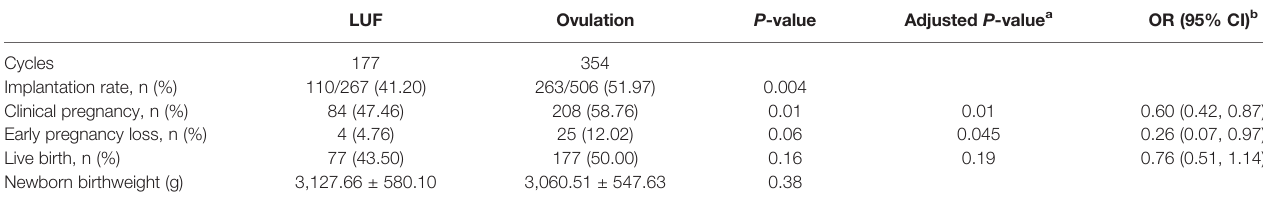
FIGURE 2 | Progesterone level (ng/ml) distribution in cycles treated with only oral dydrogesterone (20 mg daily) for LPS in the LUF group (n = 29) and the ovulation group (n = 152). The averages of progesterone were signi fi cantly different between the two groups ( P < 0.001). TABLE 4 | Pregnancy outcomes between the LUF group and ovulation group. LUF Ovulation P -value Adjusted P -value a OR (95% CI)